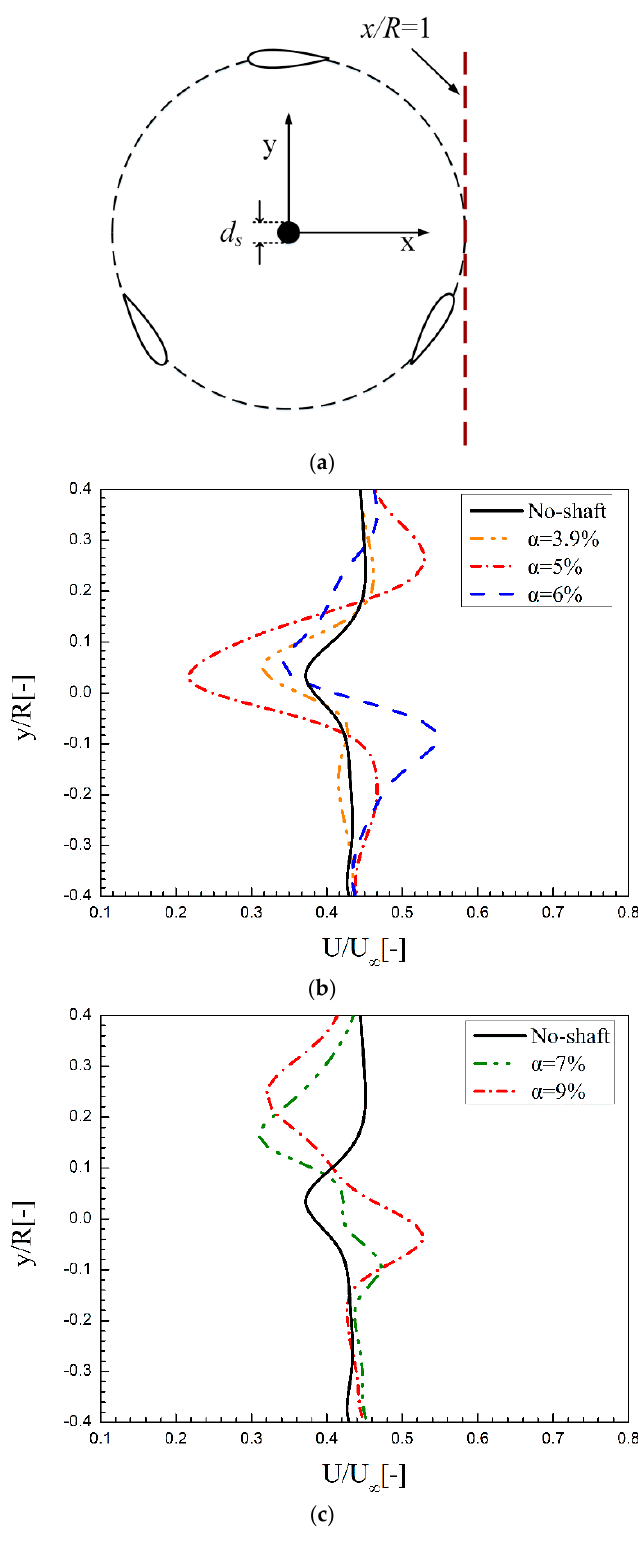
Figure 14. ( a ) Schematic of downstream analysis curve; ( b ) time-averaged dimensionless velocity magnitude on analysis curve (blade 1 at 270°); and, ( c ) time-averaged dimensionless velocity magnitude on analysis curve (blade 1 at 280°).